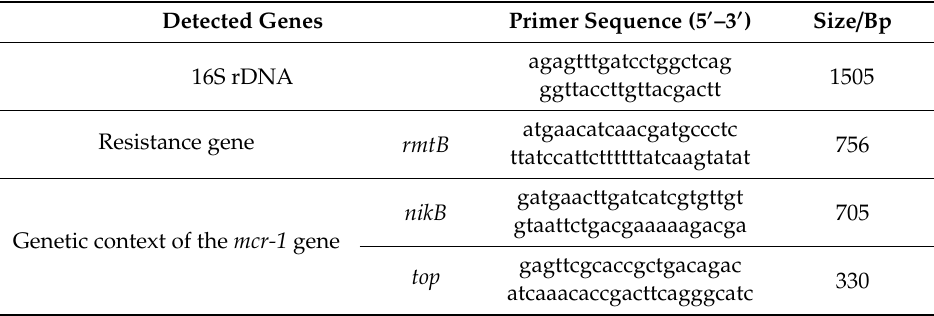
Table 1. The primers used in this